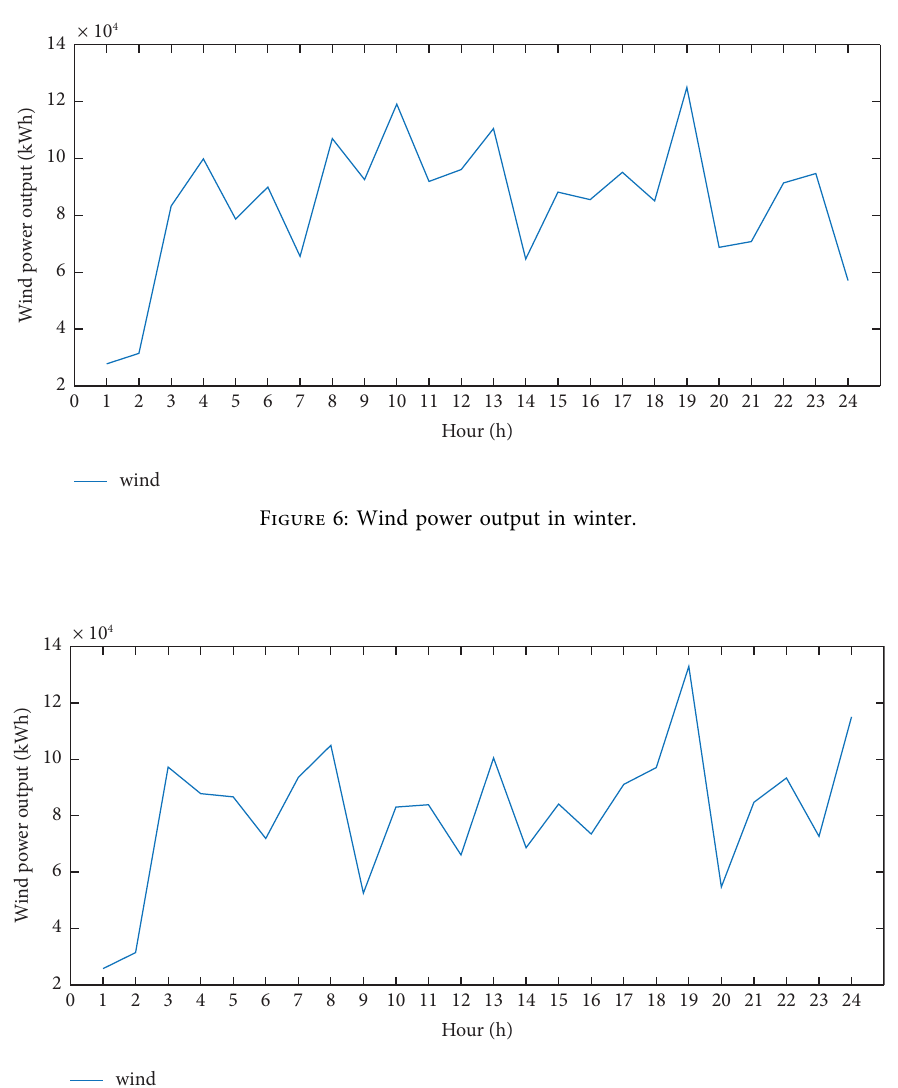
Figure 7: Wind power output in